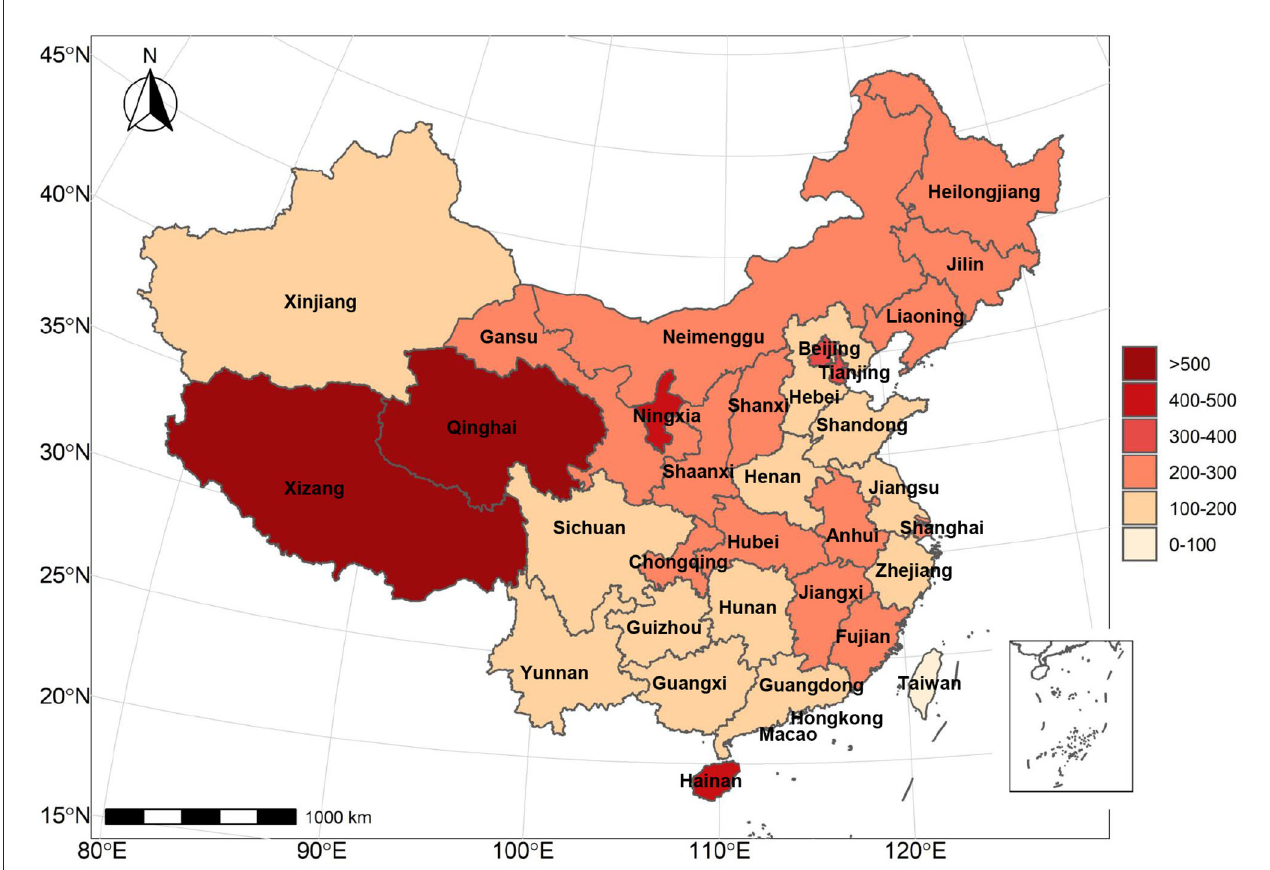
FIGURE4 The spatial distribution of average BSI changes before and after COVID-19 pandemic. Pre-COVID-19 pandemic period: from October 23, 2017 to January 22, 2020. Post-COVID-19 pandemic period: from January 23, 2020 to April 23, 2022.